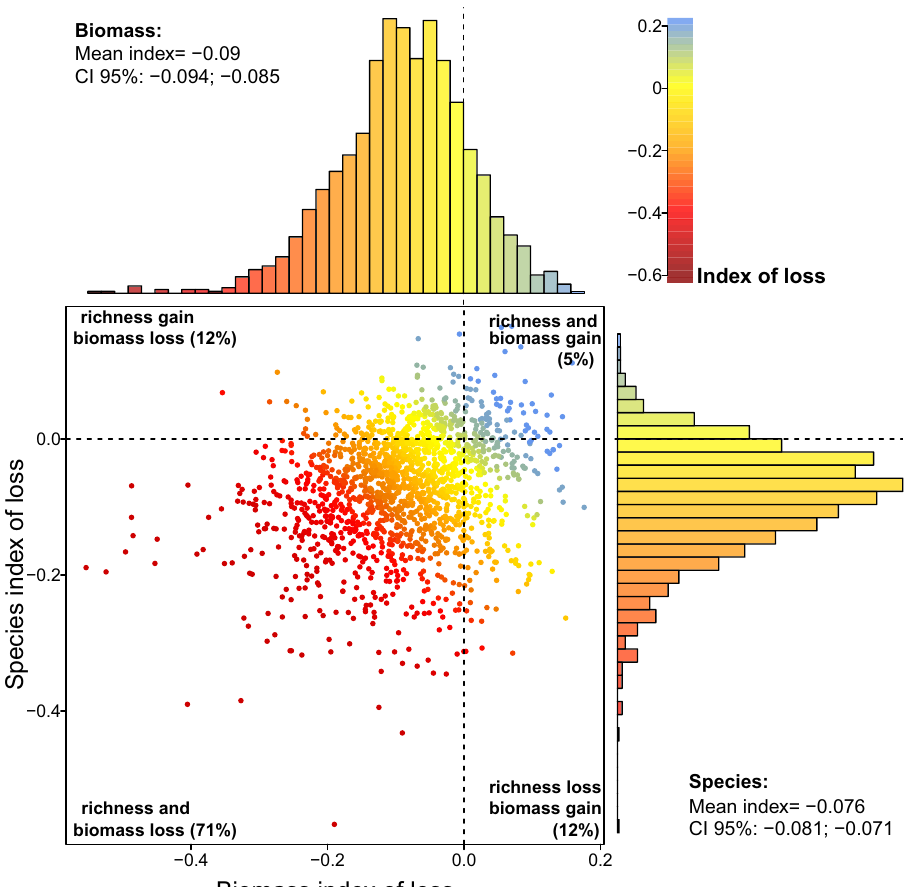
Fig. 2 The relationship between losses of species richness and forest biomass due to human-induced impacts. The standardized indices of loss were estimated for each forest survey (points), with biomass on the x -axis and species on the y -axis. By the margin of each axis, the distribution of the index is presented with the mean and the corresponding 95% con fi dence interval (CI 95%). Dashed lines separate negative indices (losses) from positive ones (gains). The index of loss is dimensionless and is highlighted by different colours ranging from dark red (high losses) to blue (gains). Pearson ’ s correlation coef fi cient between the two indices was 0.22 ( p < 0.0001, n = 1647).